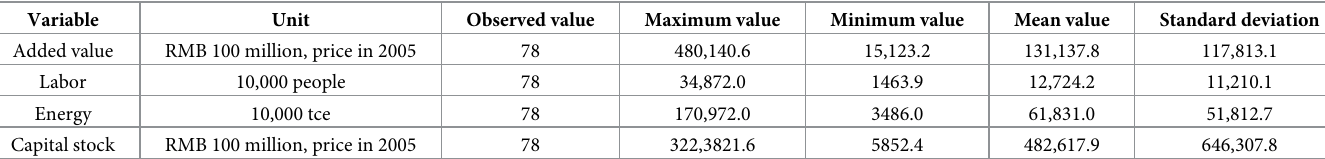
Table 1. Descriptive statistics of model variables.